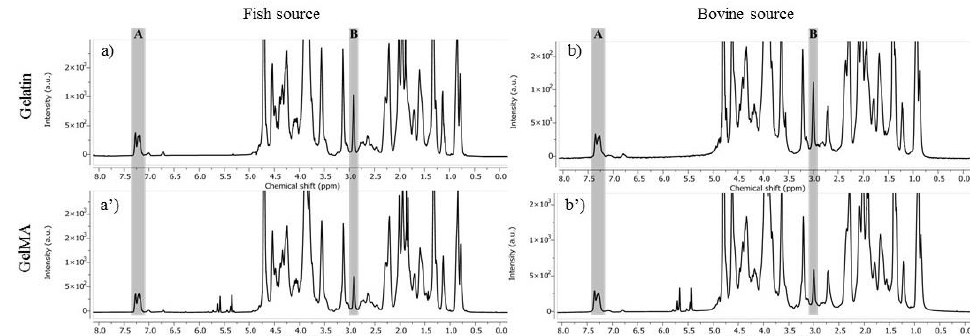
Figure 1. 1 H-NMR spectra of gelatin ( a , b ) and GelMA ( a ’, b ’) from different sources: ( A ) denote the phenylalanine signal of gelatins used as the internal reference and ( B ) denotes the signal of the amino groups in lysine residues used to calculate the %MD.